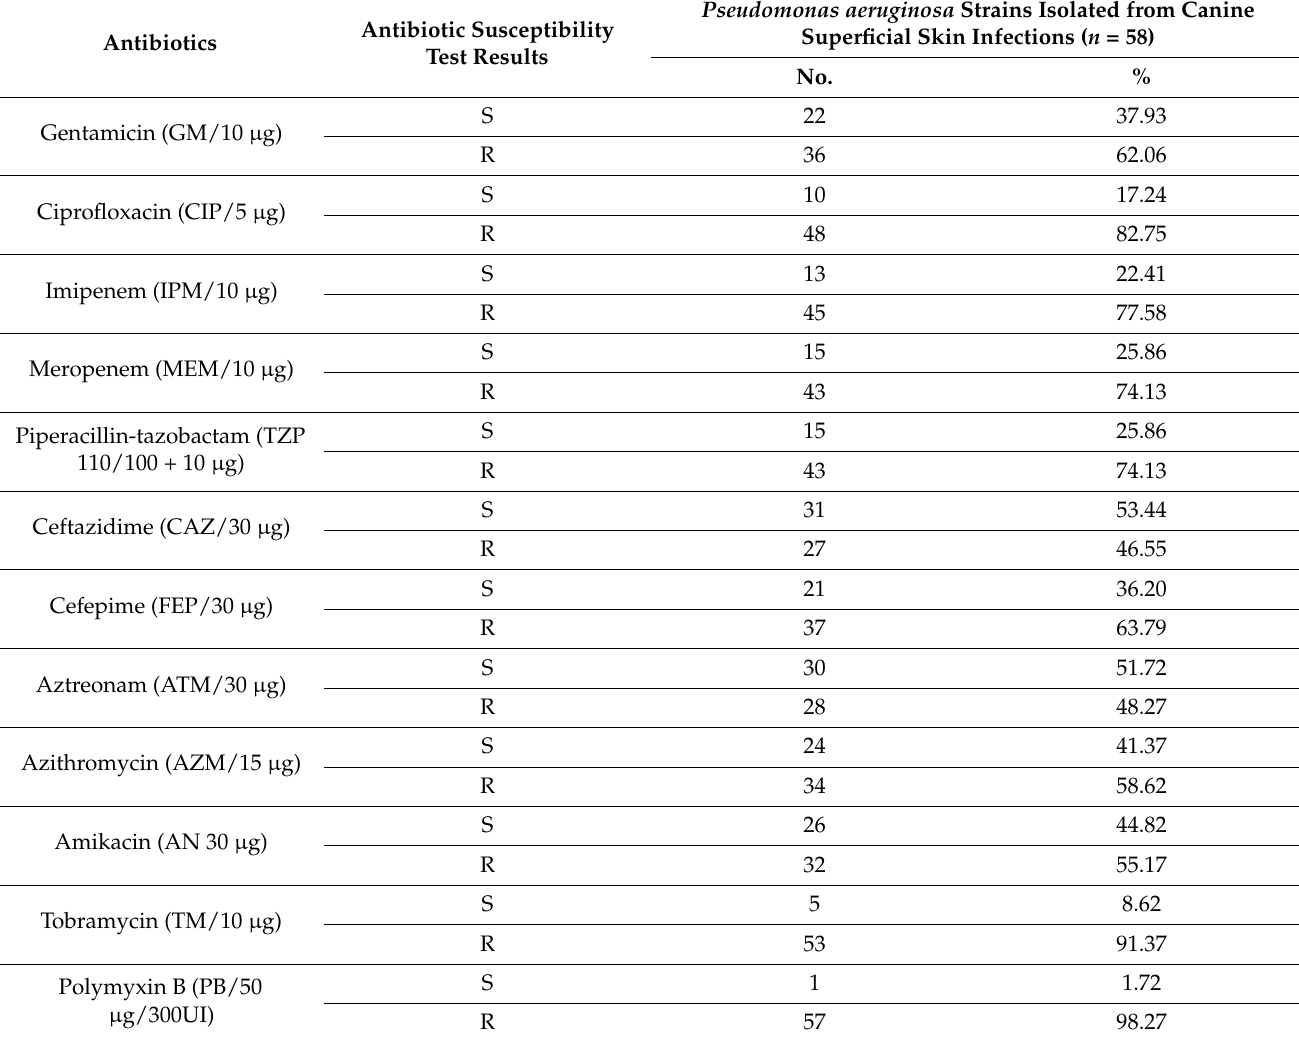
The results of the antimicrobial susceptibility tests performed on 58 Pseudomonas aeruginosa strains isolated from superficial canine infections are presented in Table 2, and the antibiotic resistance/susceptibility pattern of the multidrug-resistant Pseudomonas aeruginosa strains ( n = 18) is shown in Table 3. Table 2. Antibiotic susceptibility profile of Pseudomonas aeruginosa strains isolated from superficial canine infections. Pseudomonas aeruginosa Strains Isolated from Antibiotic Susceptibility Antibiotics Test Results